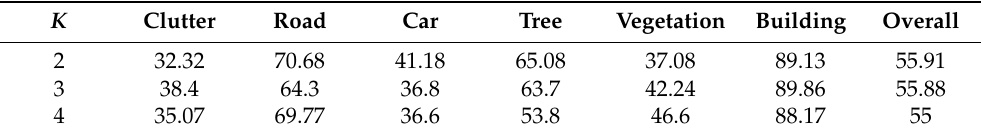
Table A2. The IoU (%) of each class with different K on POT → VAI.